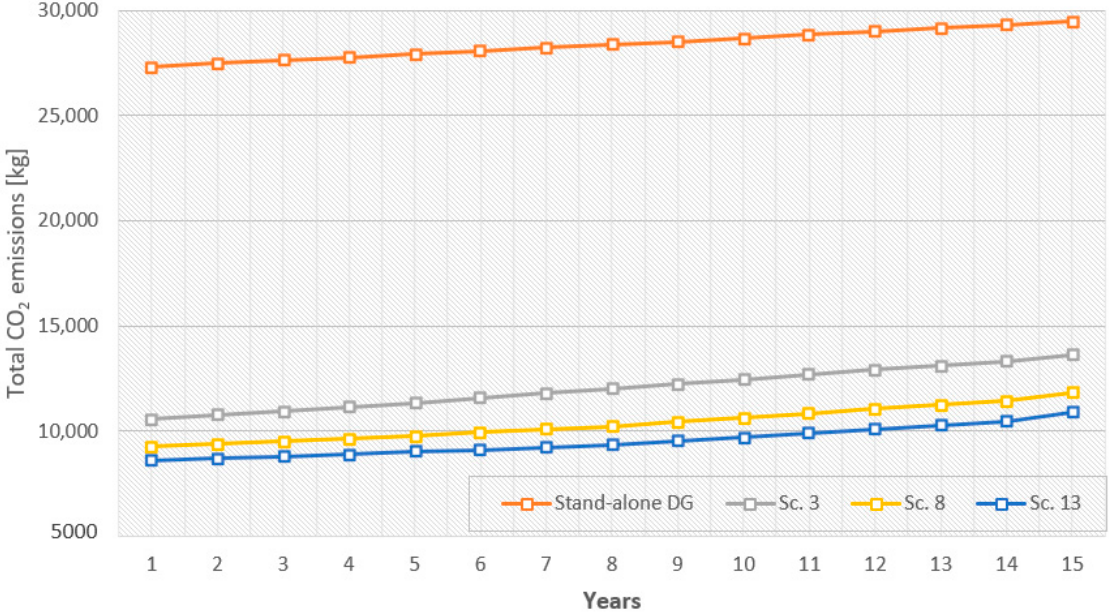
Figure 9. CO 2 emissions produced by the DG considering the scenarios 3, 8, 13, and standalone DG over the 15-year project period.